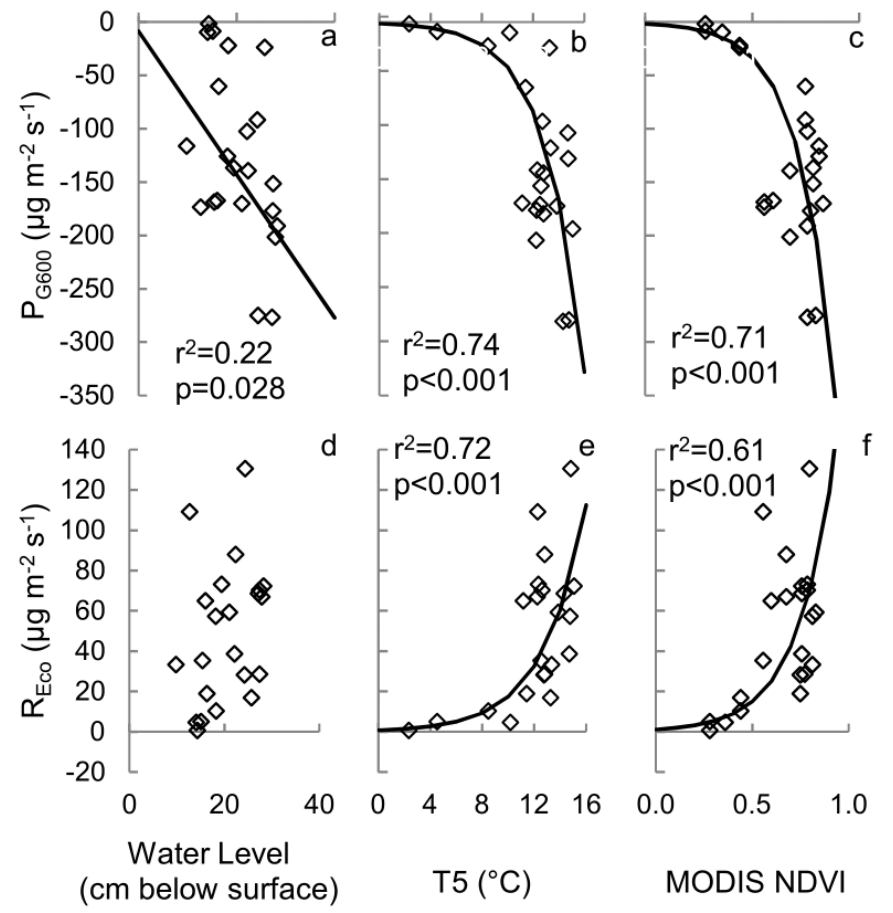
Figure 6. Relationship between photosynthesis at PPFD of 600 μmol m -2 s -1 (P respiration (R ) (d, e & f) in carbon equivalents (μg m -2 s -1 ) with water table depth (cm below ground Eco surface) (a & d), soil temperature at a depth of 5 cm (°C) (b & e) and normalised difference vegetation index (NDVI) (c & f). A positive flux is CO released to the 2